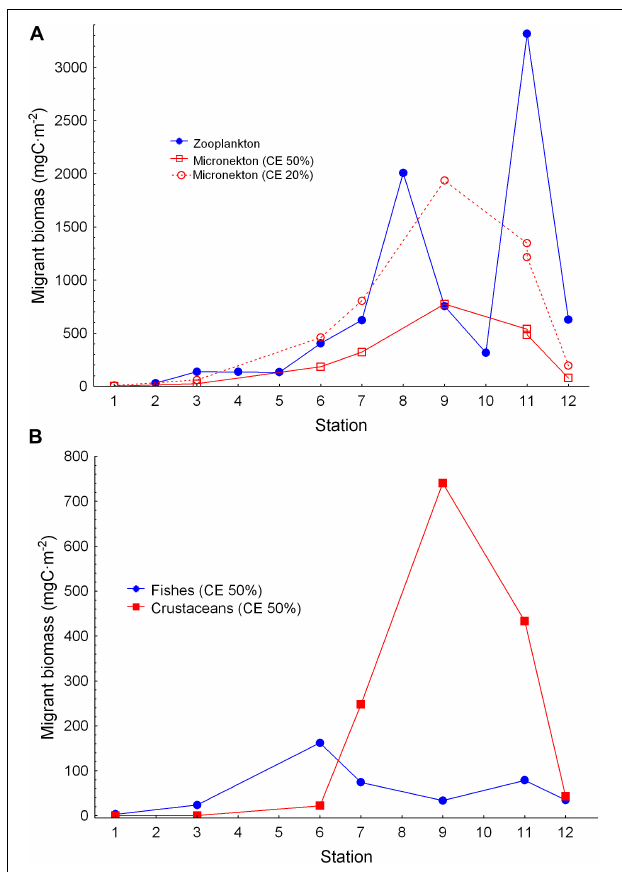
FIGURE 5 | (A) Zooplankton and micronekton migrant biomass (night minus day in the epipelagic zone) along the Atlantic transect. Micronekton migrant biomass was estimated at 20 and 50% of capture efficiency (see text) and it is depicted here for comparison. (B) Fish and crustacean migrant biomass along the